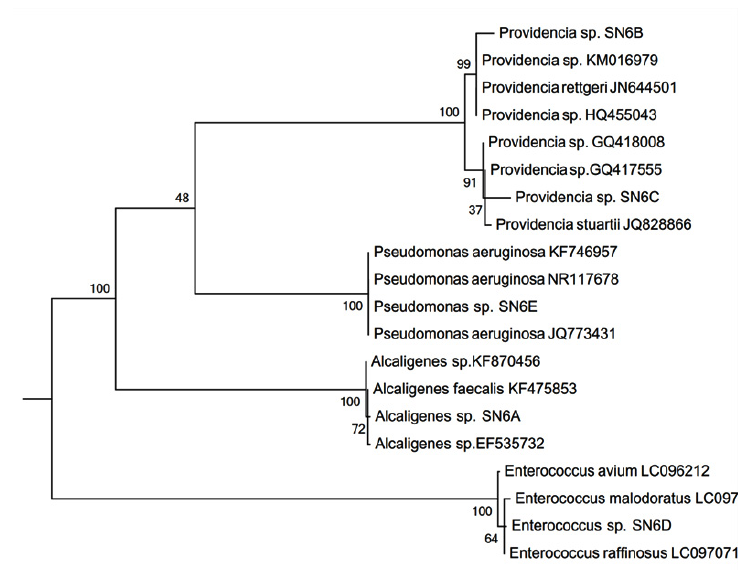
Fig. 1. Phylogenetic tree of